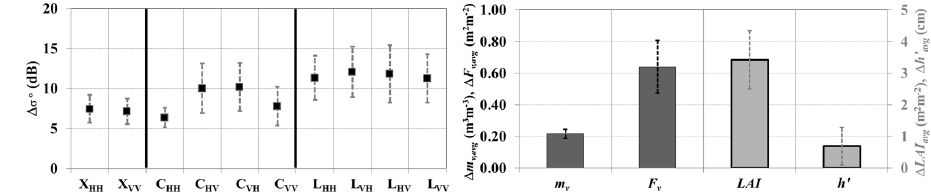
Figure 5. Observed ∆ σ ◦ avg and corresponding ∆ σ ◦ stdev (dashed lines) for all available channels are shown on the left panel; ∆ m v , avg , ∆ F v,avg (dark-grey vertical bars, primary axis), ∆ LAI avg and ∆ h’ avg (bright-grey vertical bars, secondary axis), and corresponding ∆ SSV stdev (dashed lines) are shown on the right panel.